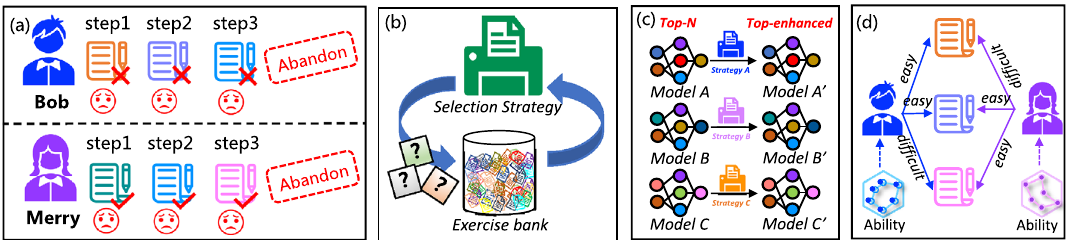
Fig. 1 Limitation of existing methods and the illustrative examples of a students exercising interactions; b large candidate action spaces; c model-specific framework; d difficulty label